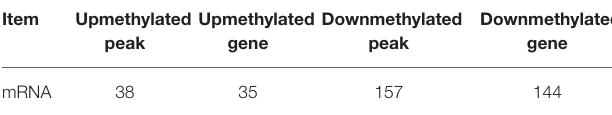
TABLE 2 | General numbers of differentially methylated peaks and associated genes.